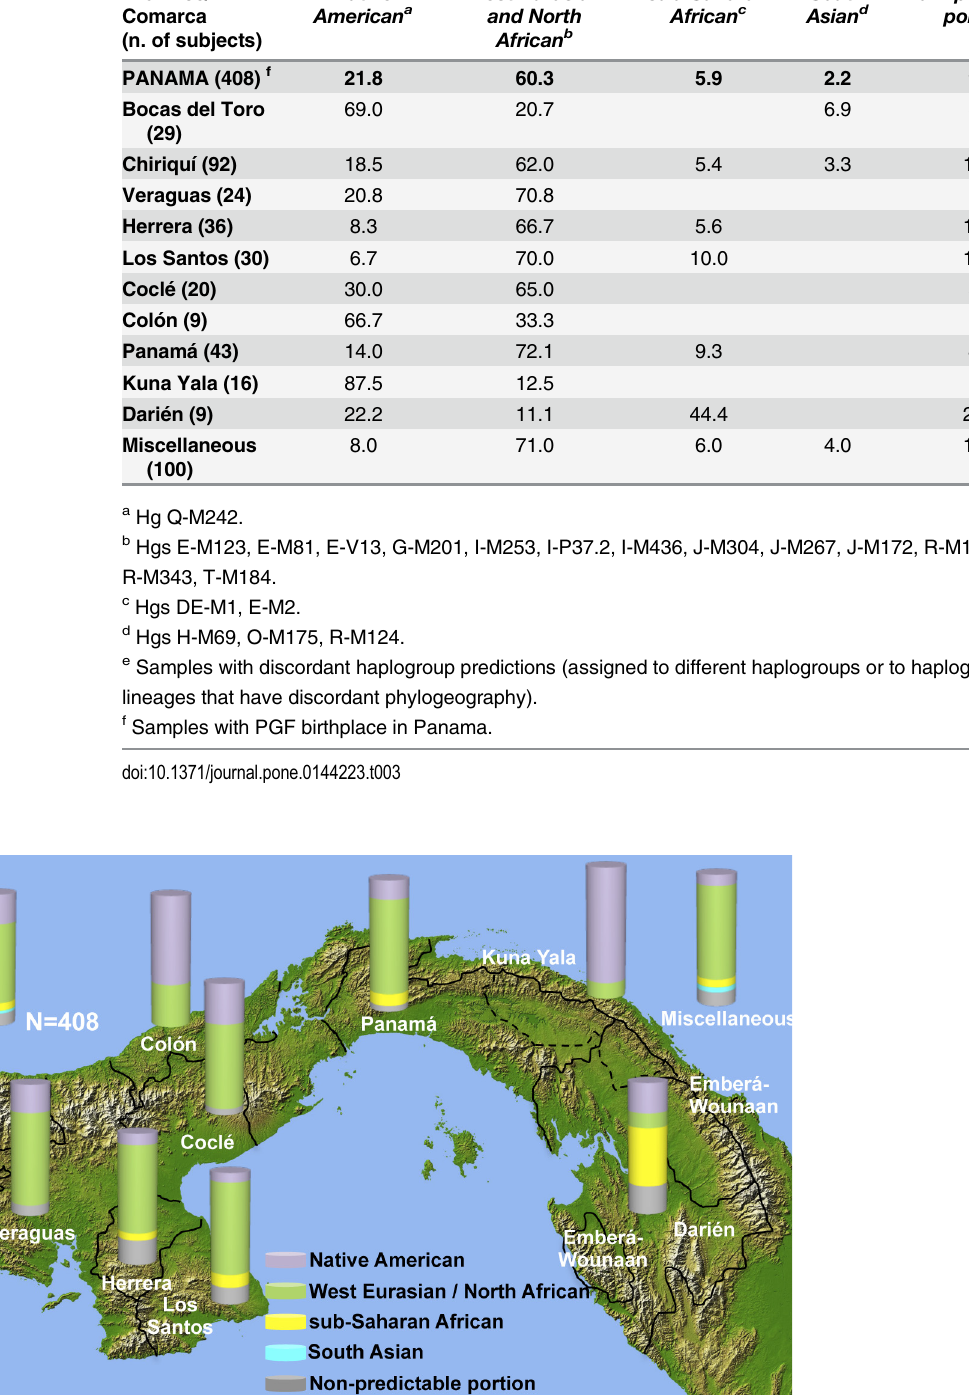
Fig 1. Spatial distributions of Y-chromosome components in Panama. Bars show Native American (violet), West Eurasian/North African (green), sub- Saharan African (yellow) and South Asian (light blue) components in each province or comarca. In grey the Y-chromosome portion with discordant haplogroup predictions. The physical map of Panama is from NASA Earth Observatory (http://earthobservatory.nasa.gov/).